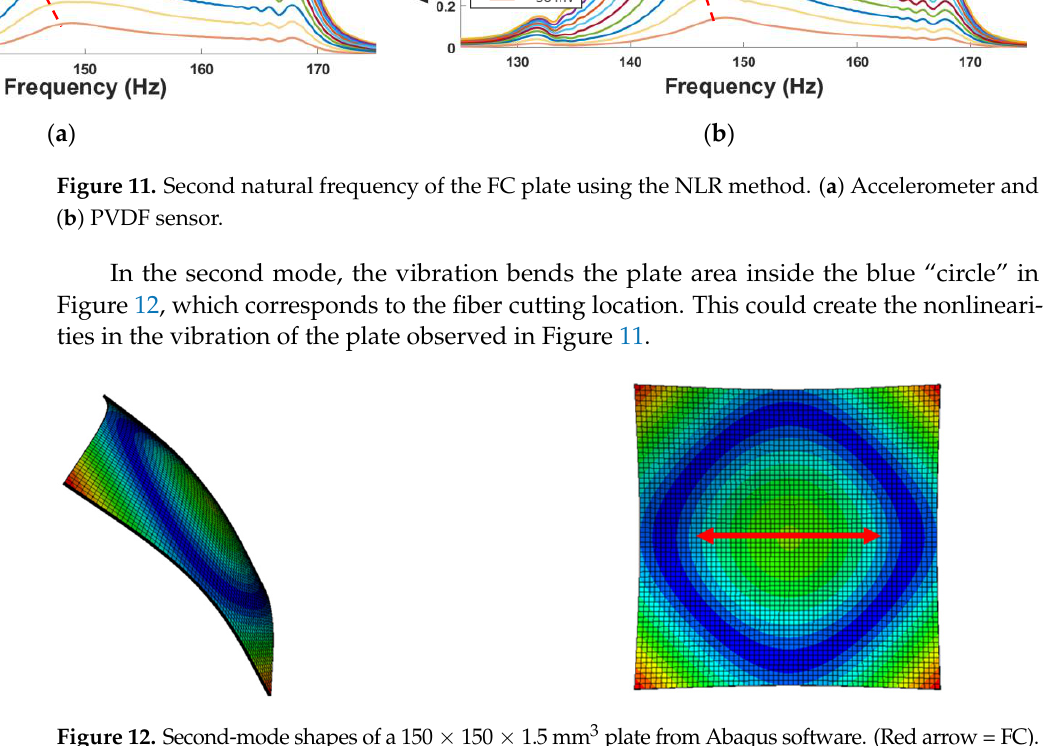
Figure 10. Frequency shift vs amplitude of excitation: second, fourth, and fifth natural frequencies. 215